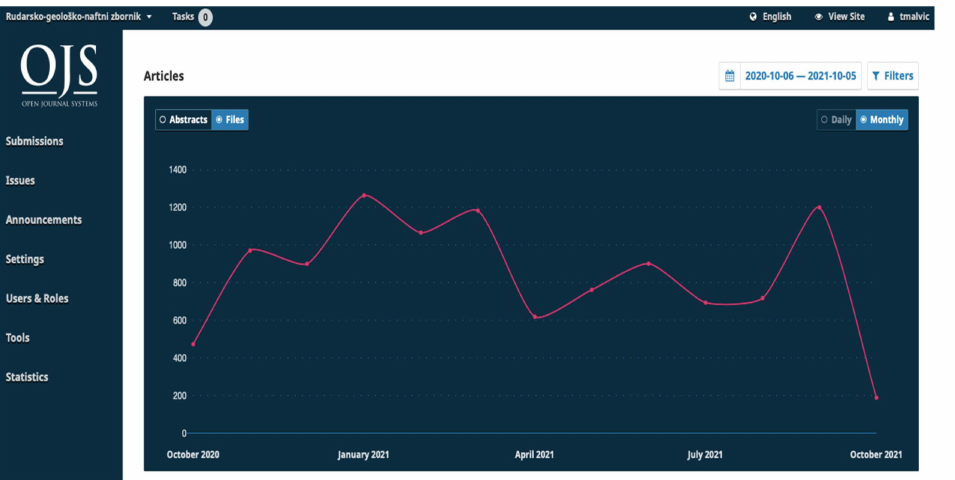
Figure 1. The number of monthly accesses to the journal’s OJS from October 2020 to October 2021—abstracts.